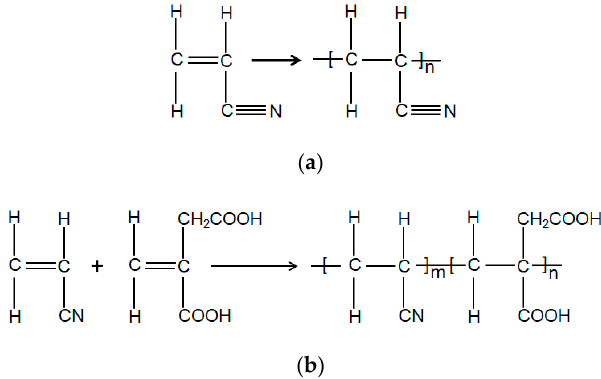
Figure 1. Synthetic route of ( a ) Polyacrylonitrile (PAN) homopolymer and ( b ) PAN-itaconic acid (IA) copolymers.